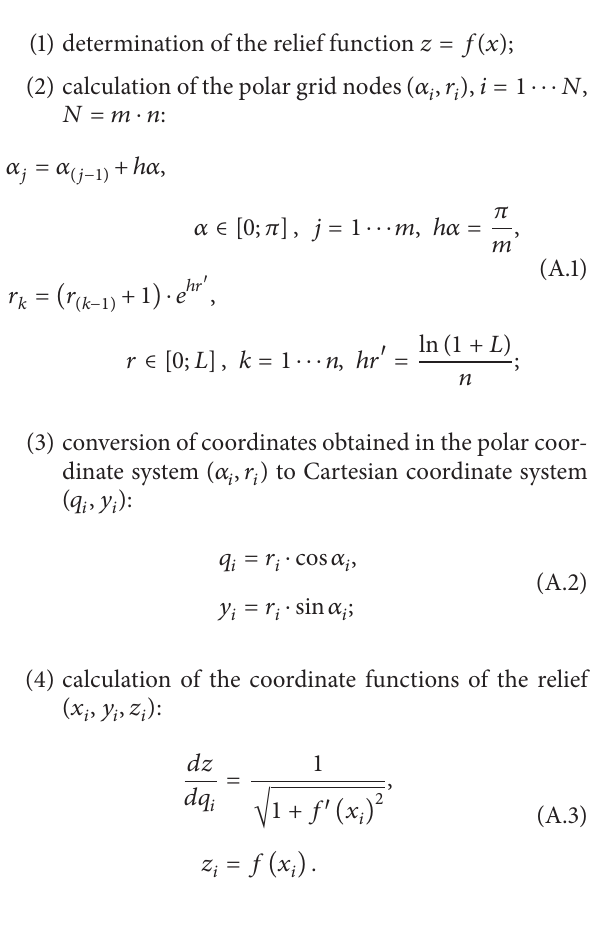
Logarithmic expanding step along the radius is calculated by the change of variables in the domain of integration Γ : 𝑟 󸀠 = ln (1 + 𝑟) . The results obtained in the polar coordinate system (𝛼 𝑖 , 𝑟 𝑖 ) are converted into Cartesian (𝑞 𝑖 , 𝑦 𝑖 ) and the coordinates of grid points (𝑥 𝑖 , 𝑦 𝑖 , 𝑧 𝑖 ) are calculated by taking into account the surface relief 𝑧 𝑖 = 𝑓(𝑥 𝑖 ) . Coordinates 𝑥 𝑖 are found by solving the differential equation 𝑑𝑧/𝑑𝑞 𝑖 = 1/√1 + 𝑓 󸀠 (𝑥 ) 2 by Runge-Kutta method; the coordinates 𝑧 𝑖 are determined by the function of relief 𝑧 = 𝑓(𝑥) . In Figure 9 a grid is constructed by the described algorithm for the relief function 𝑧 = 0 when 𝑥 < 0 and 𝑧 = sin (𝑥) when 𝑥 > 0 , 𝑥 ∈ (−4.5; 4.5)